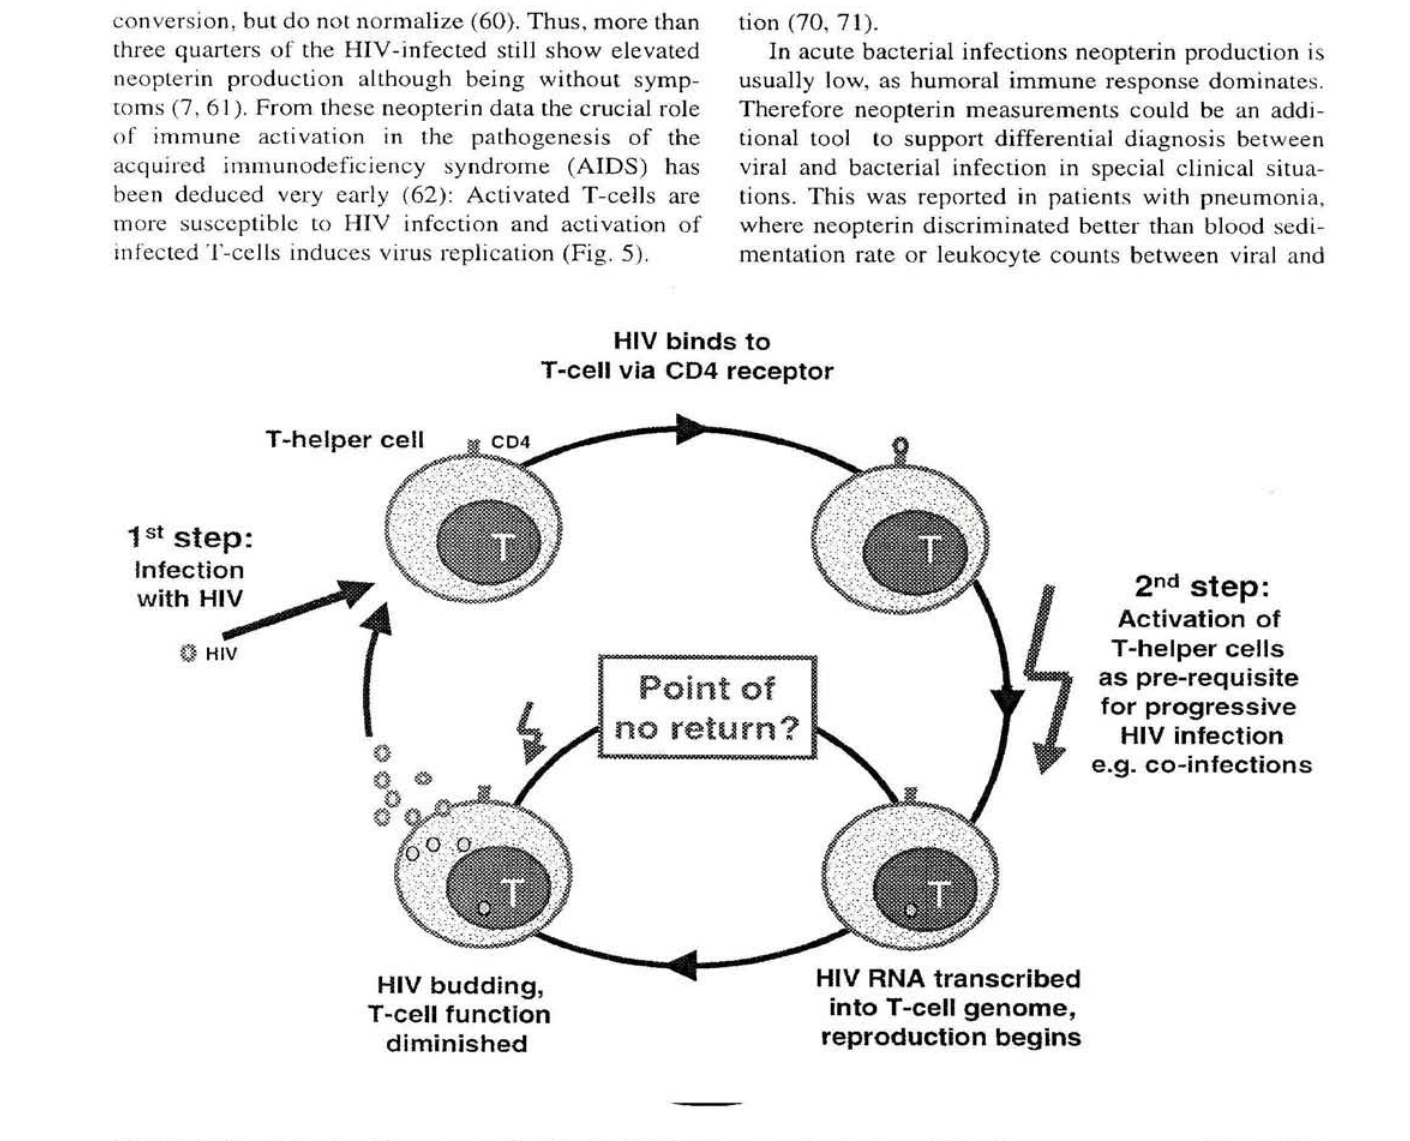
Figure 5: Crucial role of immune activation in AIDS pathogenesis: Activated T-cells are more susceptible to HIV infection and activation of infected cells induces virus replication (adapted from ref. 62) Already in the early phase of HIV infection, bacterial infection (26, 72). In protracted bacterial neopterin concentrations have prognostic impact: The infection neopterin production higher the neopterin concentration in serum or urine,